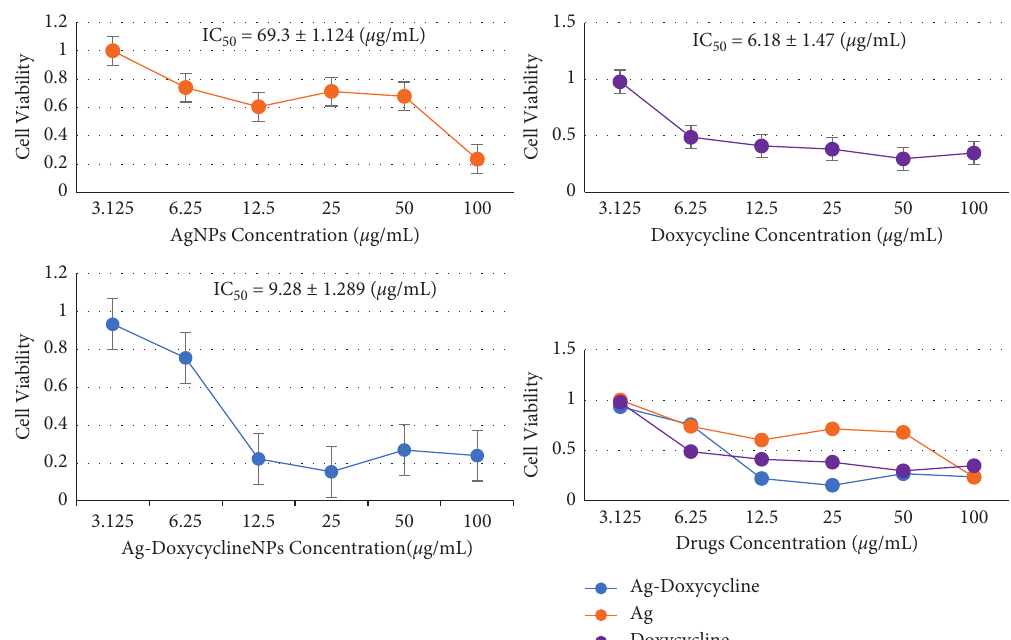
Figure 4: Effects of different concentrations of Ag-doxycycline NPs, Ag, and doxycycline on the viability of breast cancer